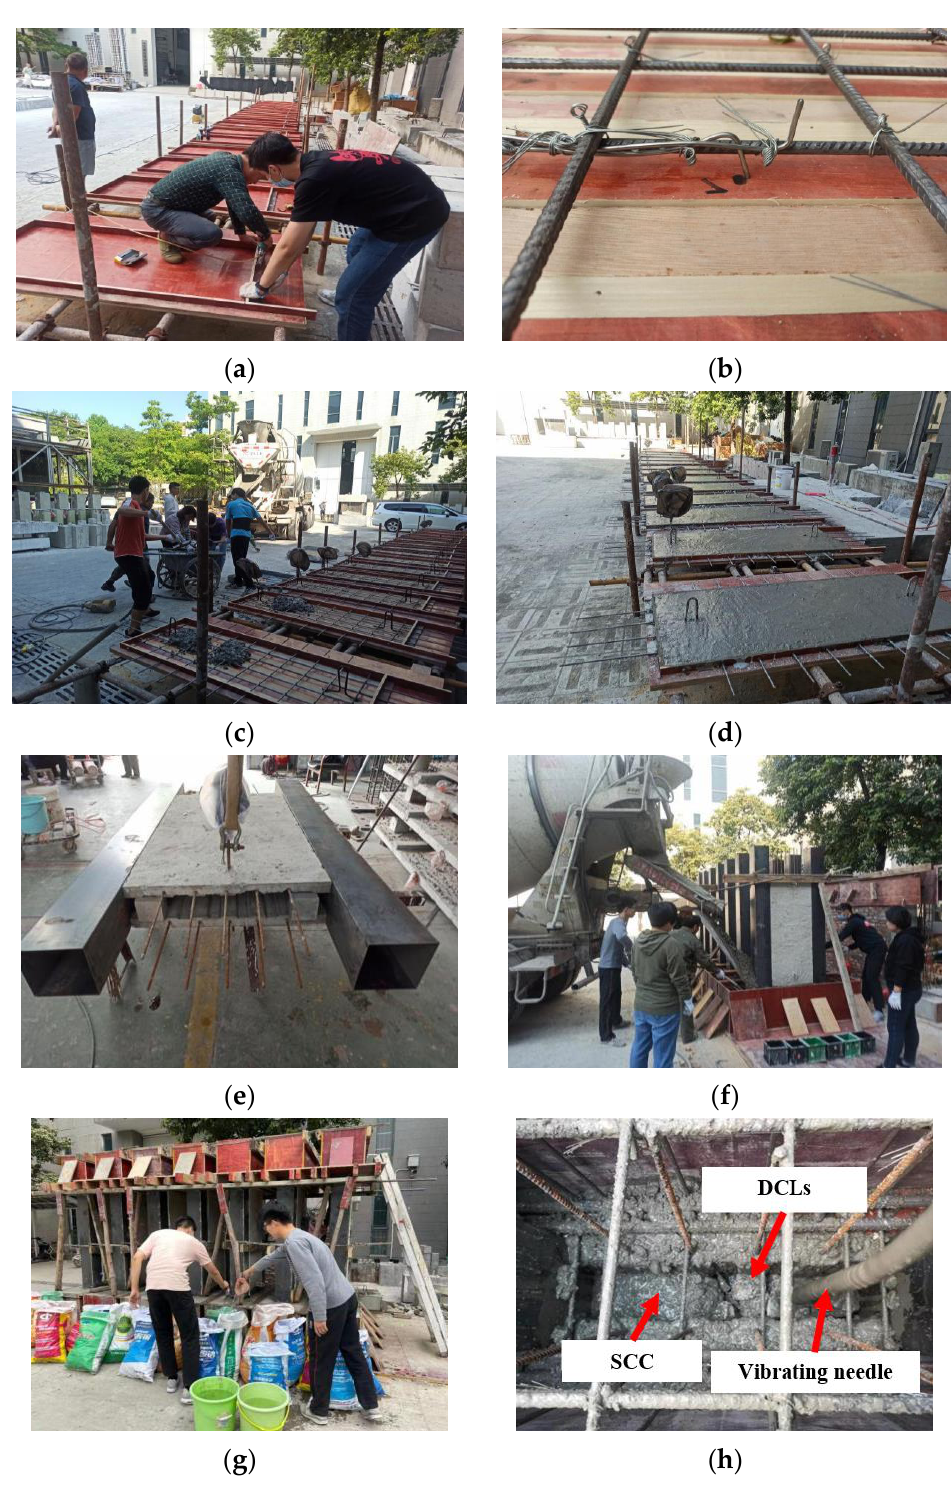
Figure 2. Concrete casting of specimens. ( a ) Formwork; ( b ) Thermocouple arrangement; ( c ) Precast wallboard pouring; ( d ) Precast wallboard pouring completed; ( e ) Precast wallboard and steel pipe assembling; ( f ) Casting of foundation beam; ( g ) Wet DCLs; ( h ) Cavity pouring. The variables studied experimentally included fire exposure time, fire-retardant coating on the edge constraint steel pipe column, and the width-thickness ratio. The basic parameters of each specimen are detailed in Table 1.